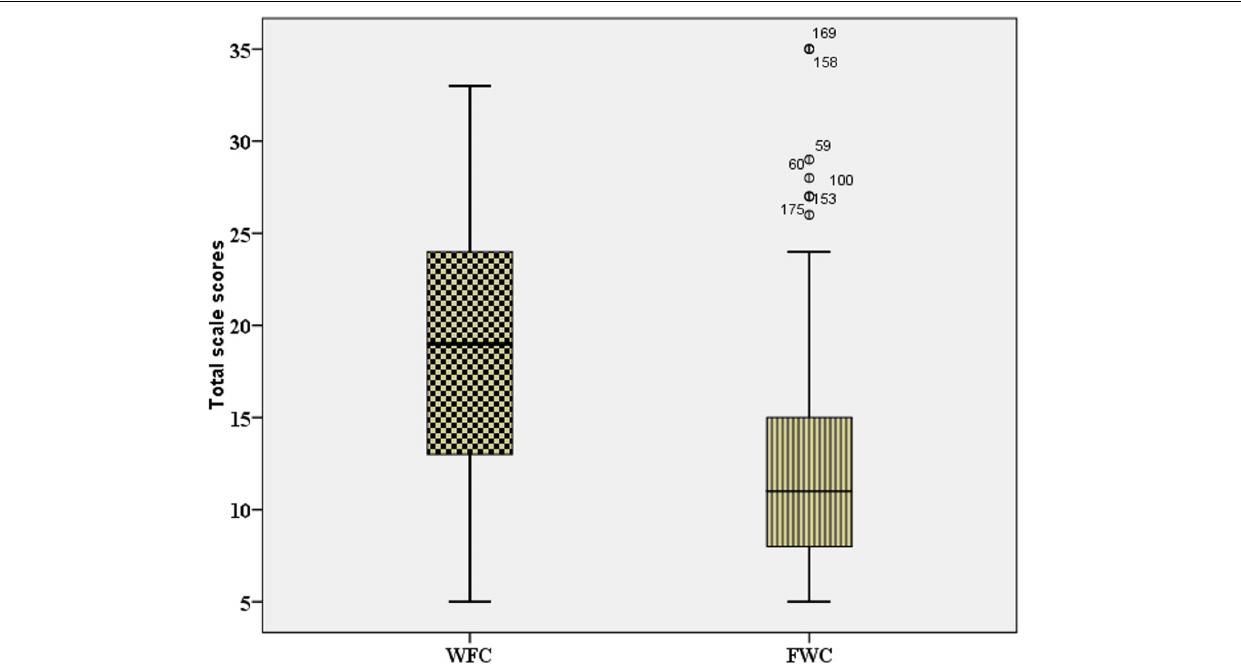
FIGURE 1 | The distribution of scores of work-family conflict (WFC) and family work conflict (FWC) for the group of Polish nurses ( N = 188). The figure shows the minimum and maximum values, the medians (the dark lines inside the boxes), the lower quartiles (the bottom lines in the boxes), the upper quartiles (the top lines in the boxes), and extreme values (outliers) of the